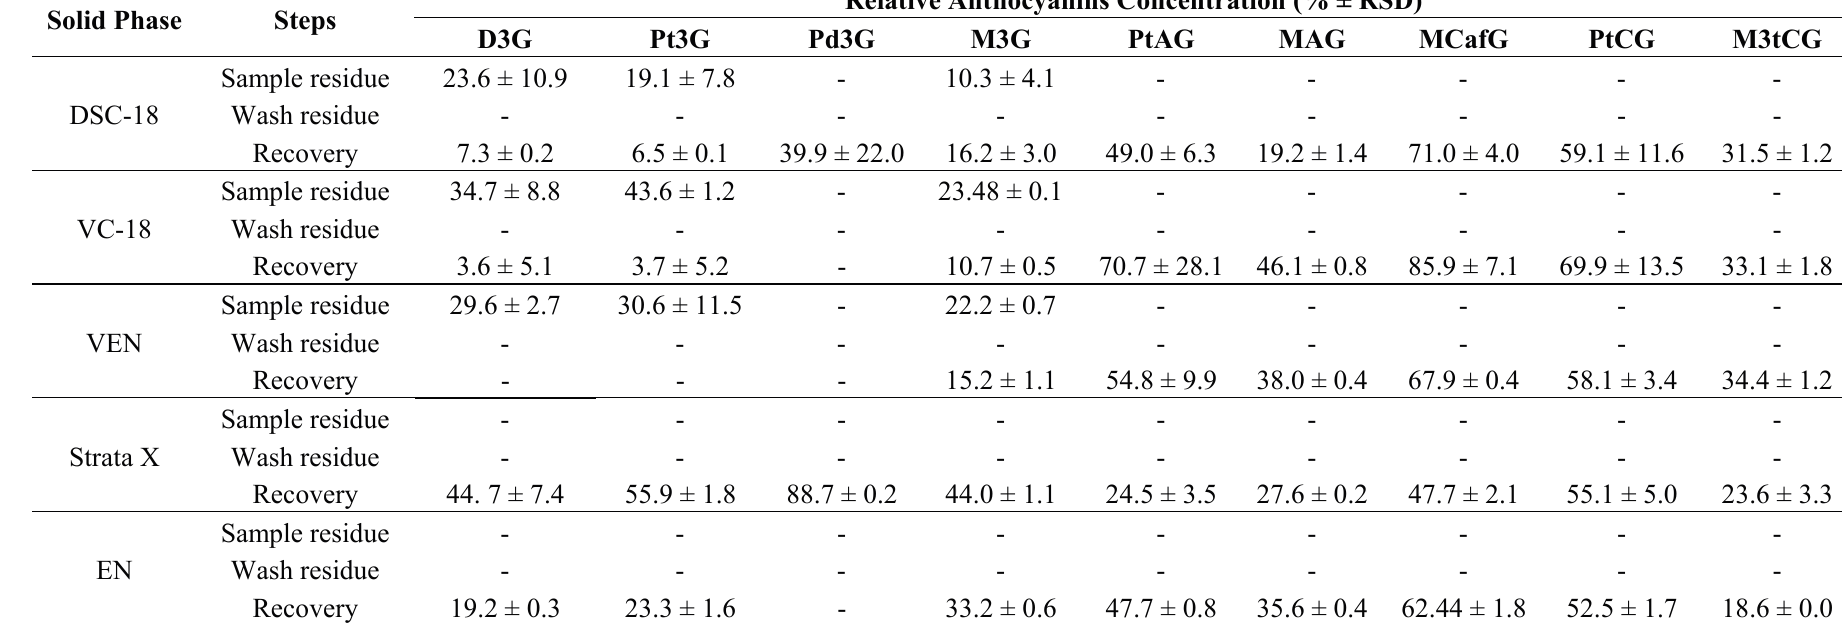
Table 1. Relative anthocyanin concentrations (% ± RSD) for sample and wash residues and recoveries obtained with the assayed SPE cartridges ( n =